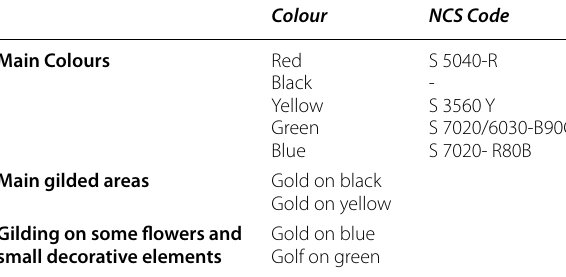
Table 1 Colours used in the room